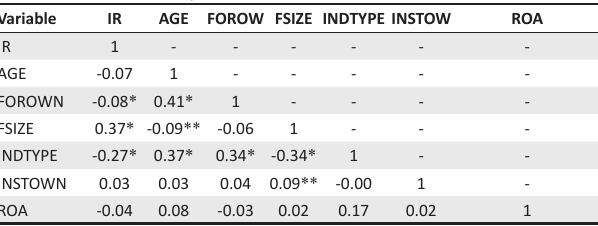
TABLE 4: Correlation analysis.